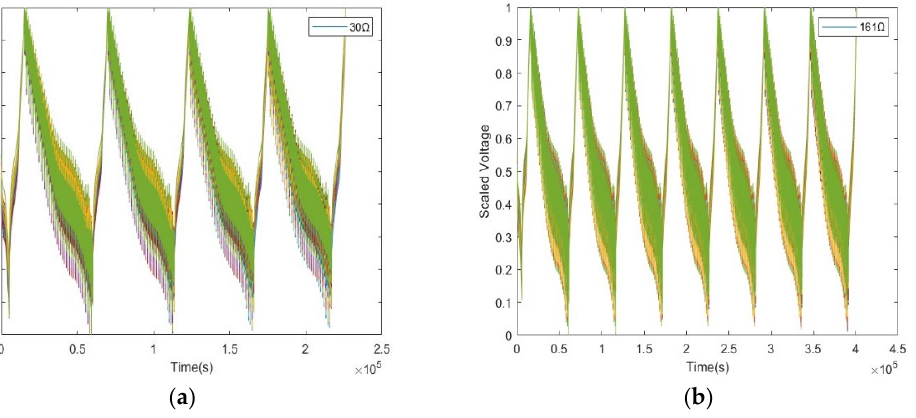
Figure 8. Normalized voltage curves: ( a ) ISC resistance of 30 Ω ; and ( b ) ISC resistance of 161 Ω .